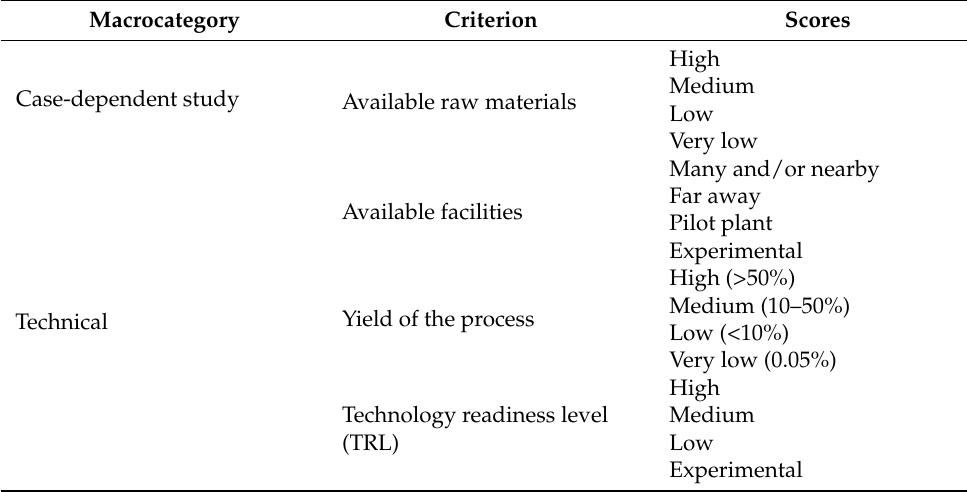
Table 3. Criteria and scores for the evaluation of economic and technical feasibility of a new product from by-products/discards or low-value fish (modified from Iñarra et al. [45]). Each criterion has 4 possible scores (high, medium, low, and null) reported in descending order in the